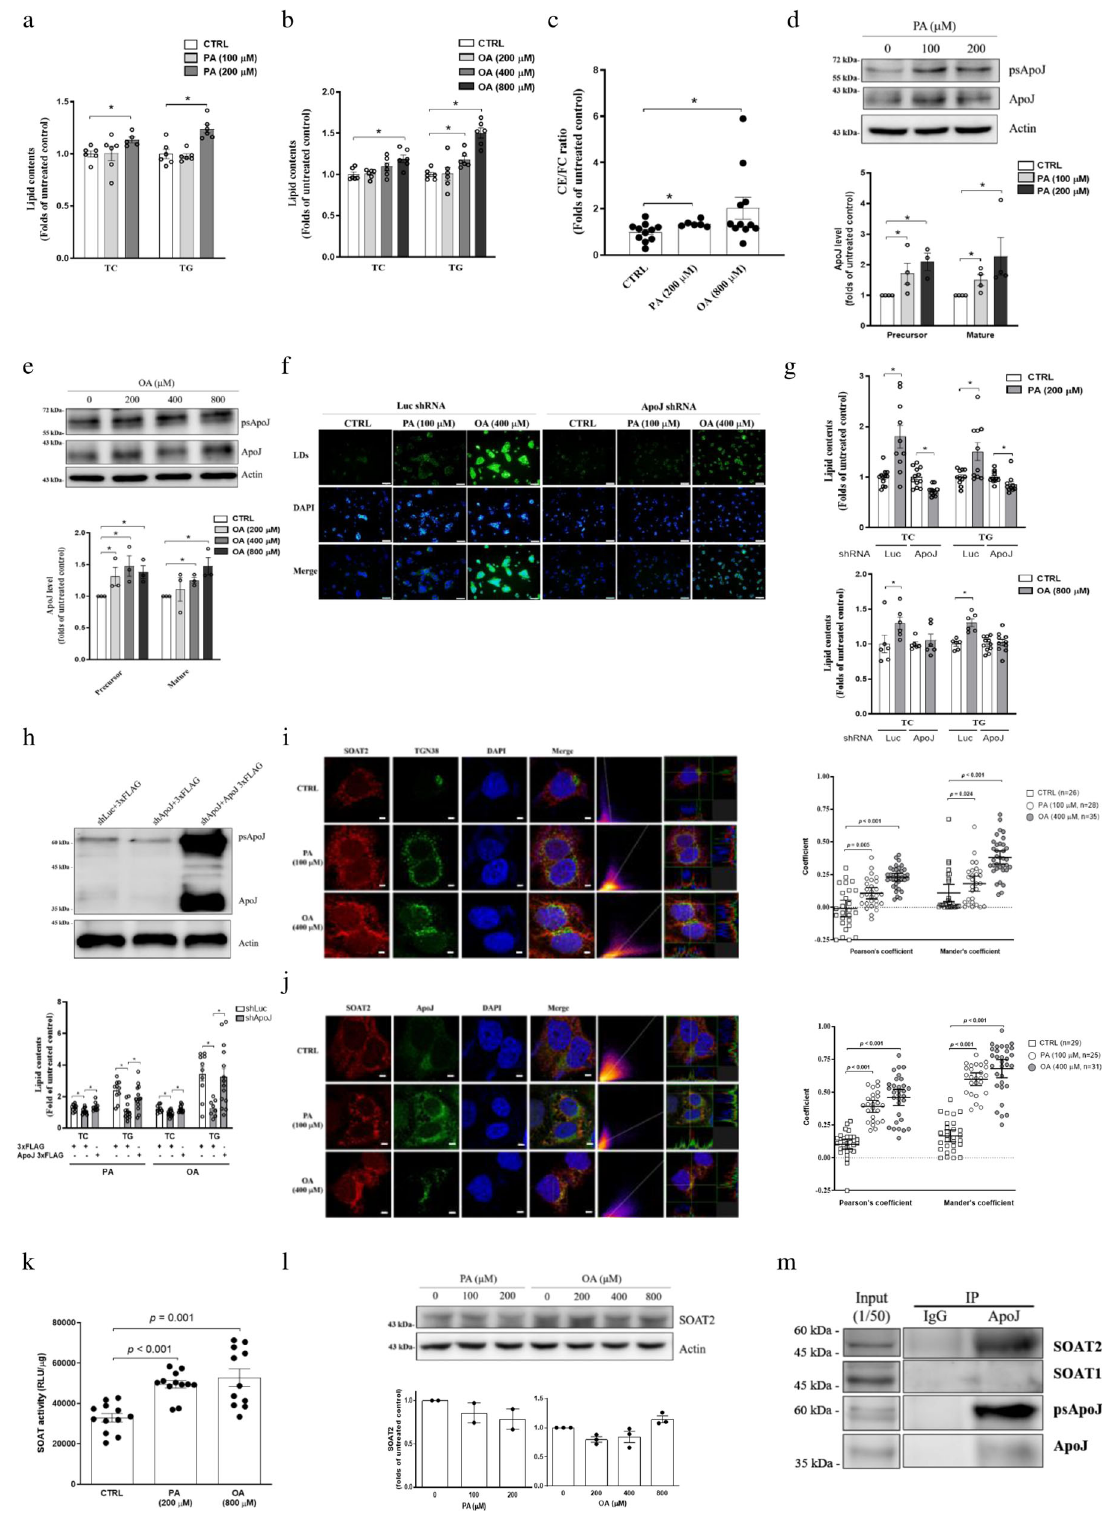
lipid accumulation (the present study). Our results suggested that intracellular ApoJ-mediated SOAT activation might respond to stress inducers originating from either obesity, such as FFAs, or non-obesity, such as HCV infection, and provide CE for hepatic LD enlargement. The results further showed high serum ApoJ con- centration in patients with metabolic steatosis and